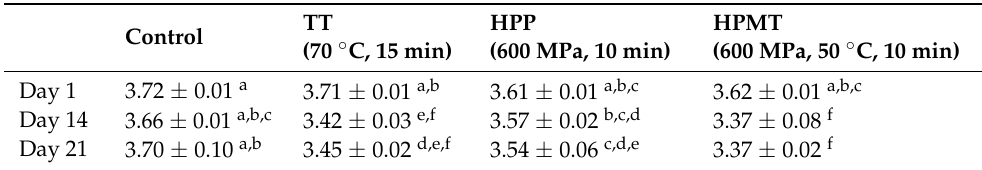
Table 2. Variation of pH in peach–strawberry purees during refrigerated